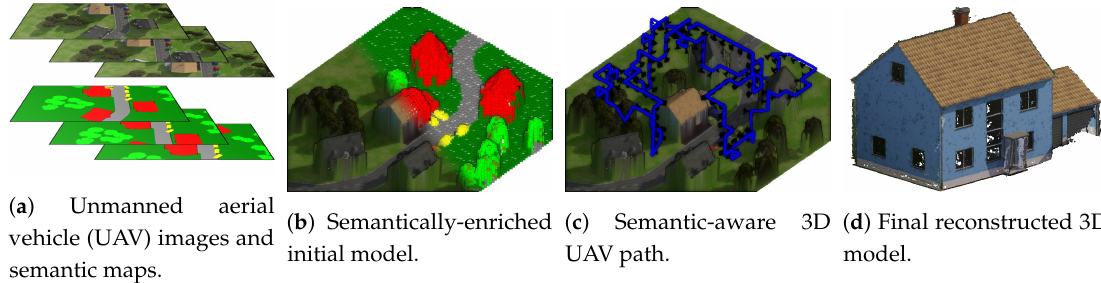
Figure 1. Proposal of our UAV path planning methodology for generating 3D reconstructions of individual objects considering path restrictions based on semantics. A 3D proxy model is generated using a set of geo-referenced UAV images from a simple flight above the environment which is further enriched by transferring 2D segmentation labels into 3D space, defining free, conditionally accessible and prohibited airspaces ( b ). A graph-based optimization estimates a collision-free trajectory for image acquisition viewpoints considering restricted airspaces while minimizing the respective path length ( c ). The acquired images of the traversed trajectory are suitable to generate high-resolution 3D reconstruction models ( d